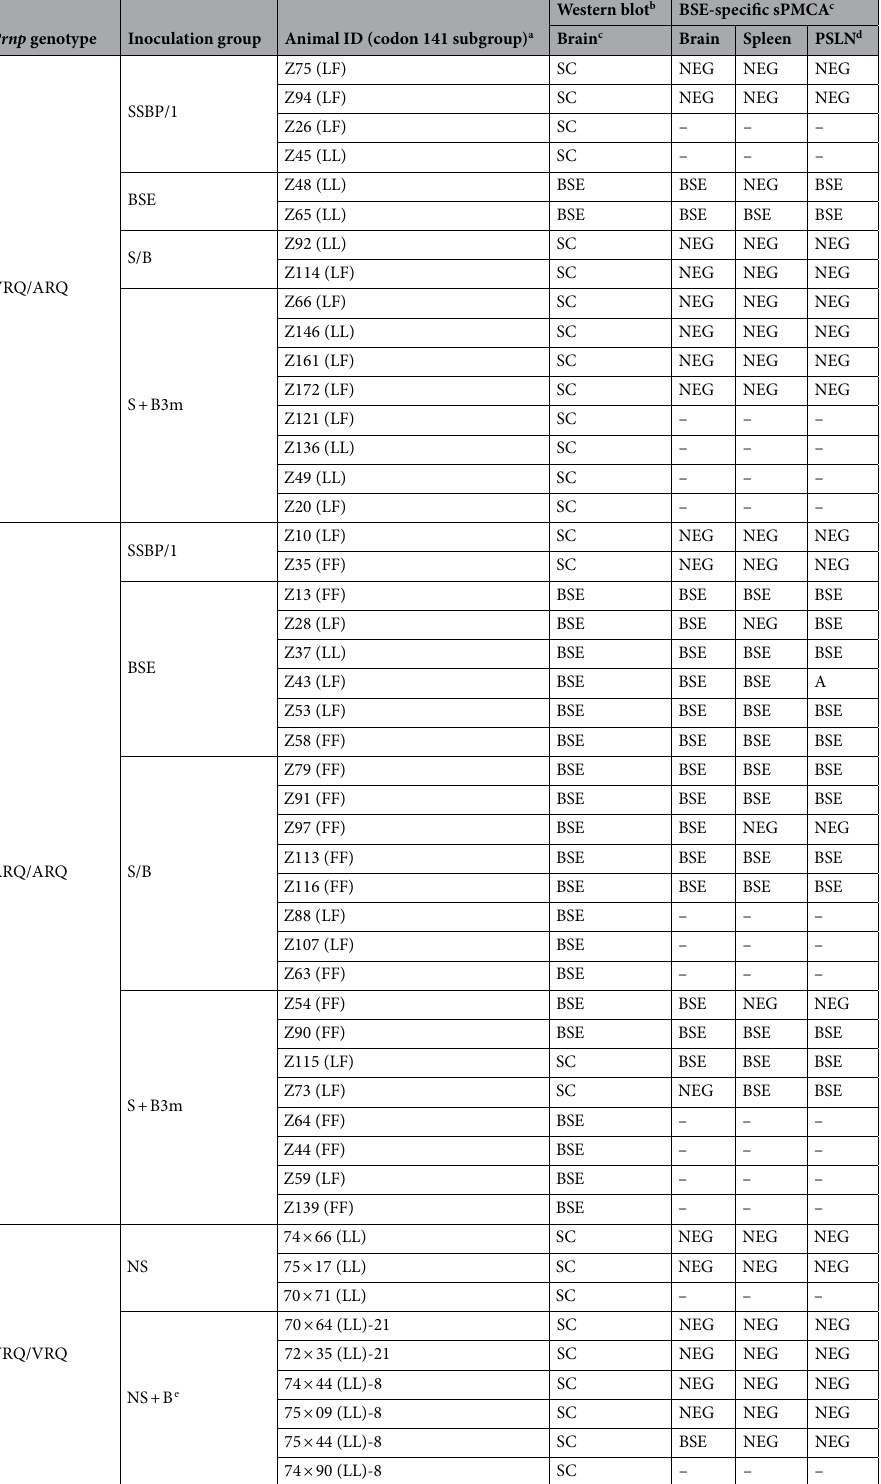
Table 2. BSE-specific sPMCA test results compared with BSE and scrapie PrP Sc determination by western blot analysis for individual sheep. a Animal codes are given (e.g. Z75). b SC: Scrapie. c NEG: negative for BSE by PMCA, –: not done, A: sample not analysed due to autolysis. d PSLN: prescapular lymph node e − 8 or − 21 indicate superinfection with BSE was carried out at 8 or 21 months of age,